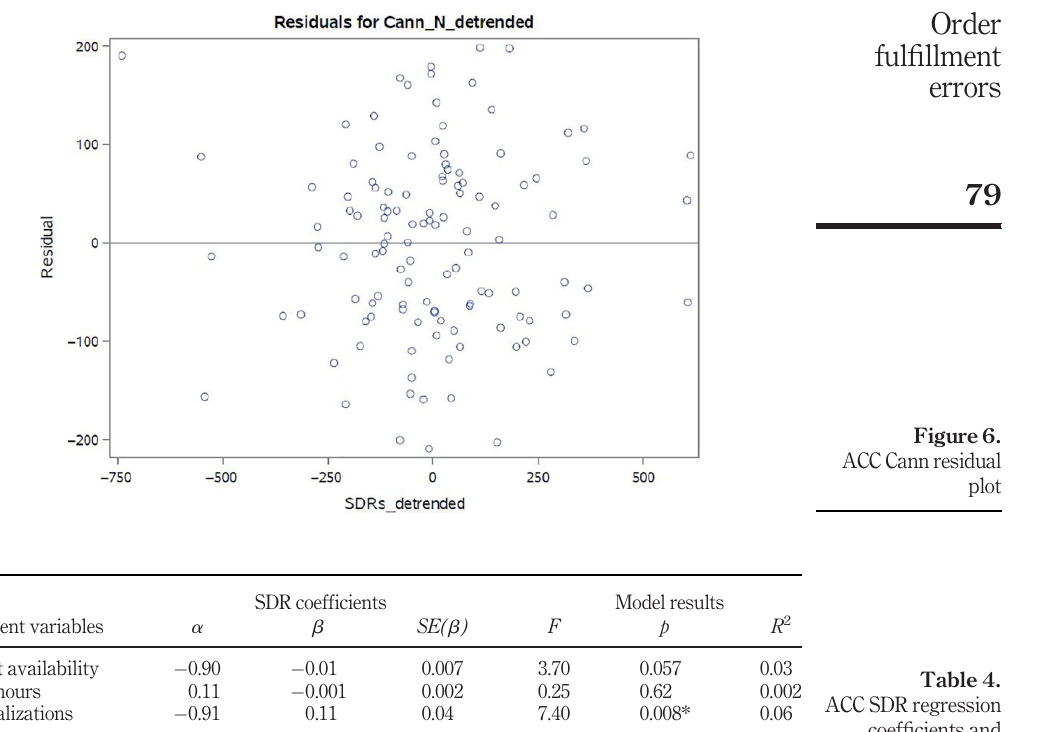
Table 4. ACC SDR